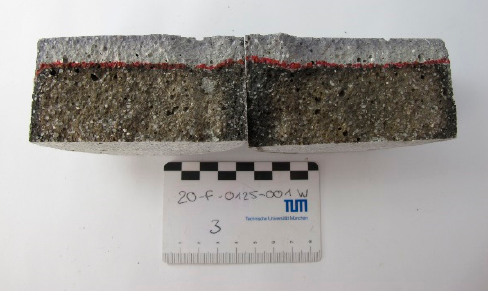
Figure 9. Cross-section of a 3D-printed D RCM specimen (tested in 90°); light gray color on top: area with penetrated chloride; dark gray/brown color below: area without chloride.